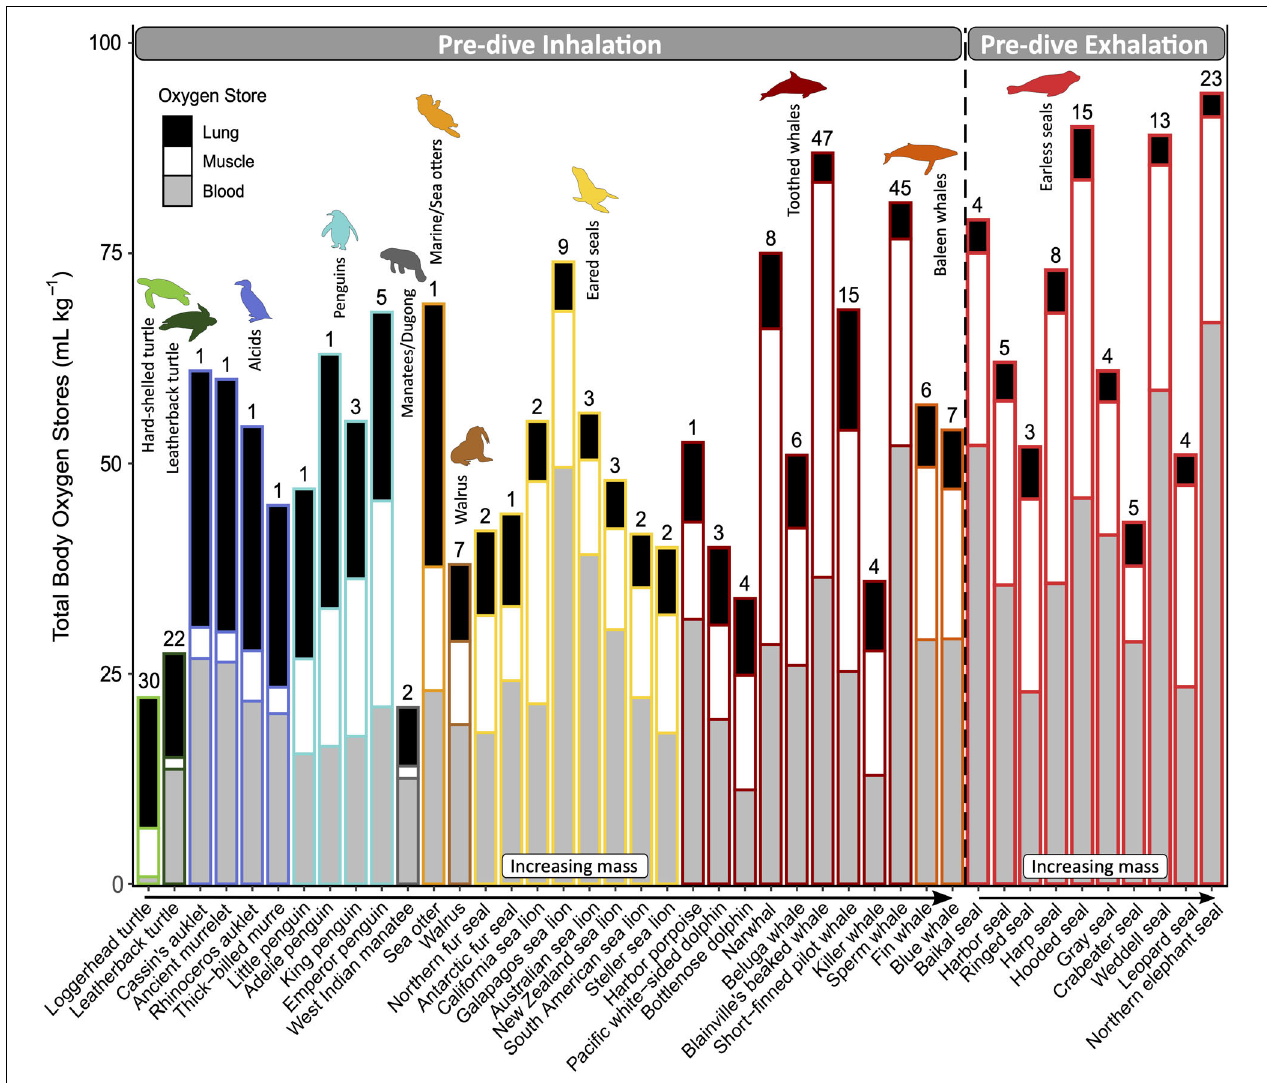
FIGURE 4 | Magnitude and distribution of mass-specific total body oxygen stores and the relative contributions of each oxygen-storing compartment: lung (black), muscle (white), and blood (gray). Divers are grouped by those that inhale or exhale upon descent and ordered within each common name group by increasing body mass. Routine dive duration (minutes) is indicated above the bar for each species. All species of sea turtles, seabirds, and marine mammals for which this data is available to the best of our knowledge were included. Refer to Supplementary Table S3 for data